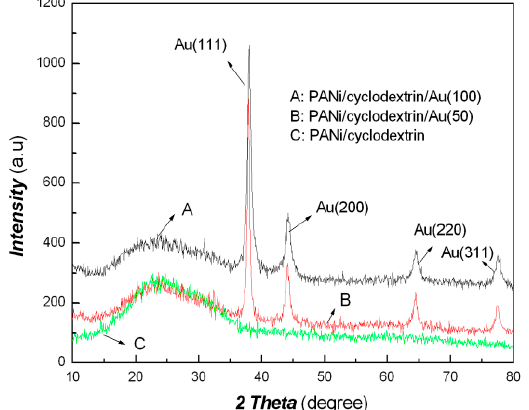
Figure 8. Representative XRD of a series of Au/PANi nanocomposites functionalized with beta-cyclodextrin (A: PANi/cyclodextrin/Au (100); B: PANi/cyclodextrin/Au (50); C: PANi/cyclodextrin).